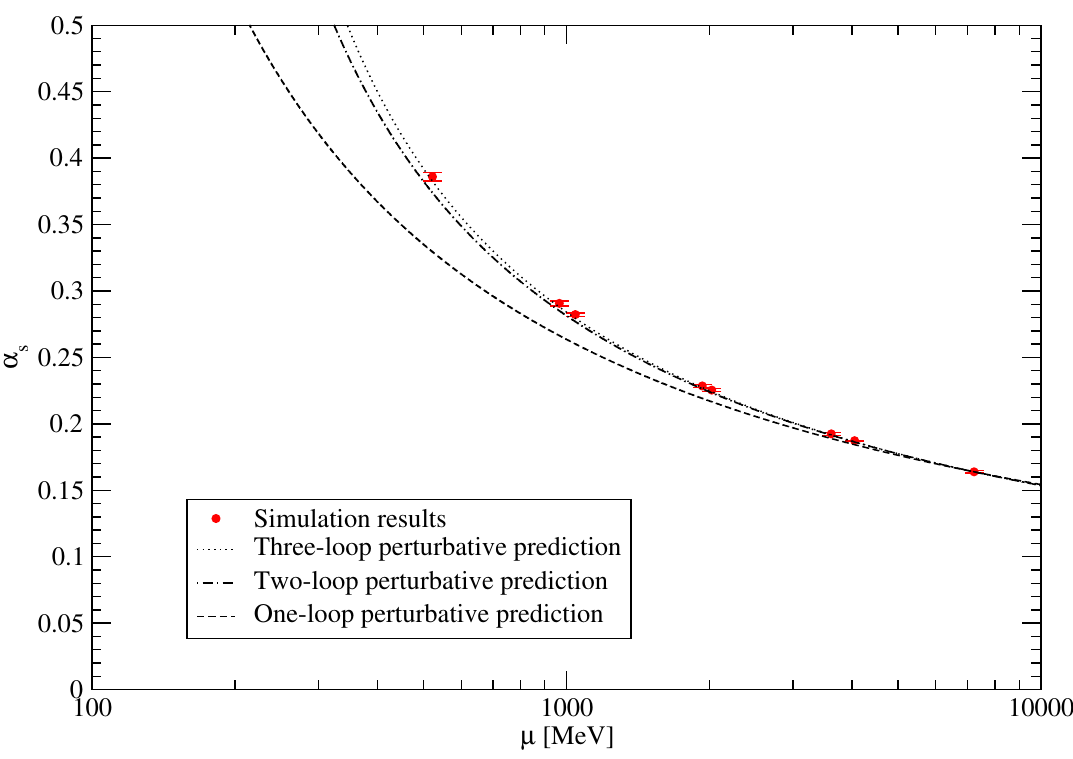
Figure 5 . The running coupling (cid:11) = g 2 = (4 (cid:25) ) of SU(2) Yang-Mills theory, as a function of the s momentum scale (cid:22) = 1 =L . For comparison, the one- (dashed curve), two- (dash-dotted curve) and three-loop (dotted curve) perturbative predictions are also